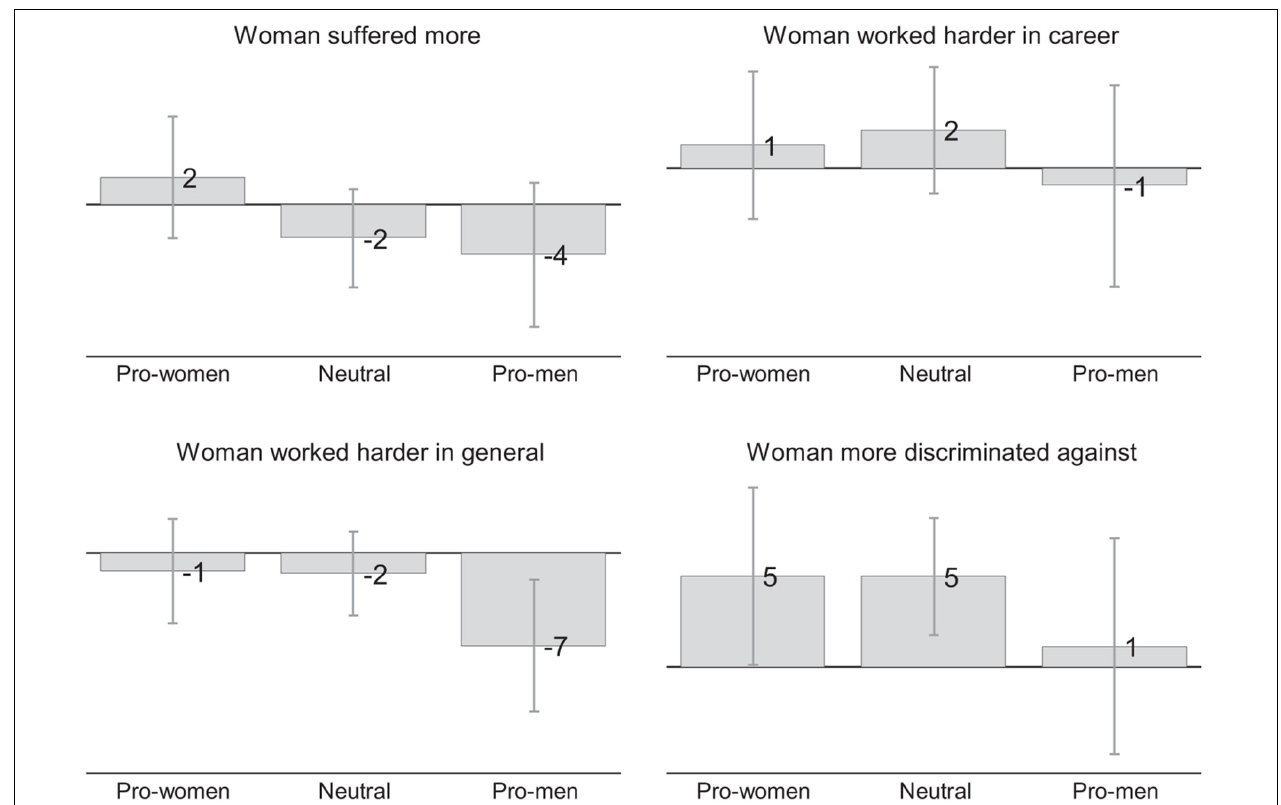
FIGURE 7 | Beliefs about women and men in control scenarios (Qualtrics). This figure is based on responses of Qualtrics respondents who were randomly assigned to the control group. The numbers shown in the figure show belief scores which can range from –50 to +50 where 0 indicates gender neutrality and positive values mean that the statement in the subfigure heading applies more to women. For example, positive values in the left-most figure mean that respondents believe that the women showed in the previous scenarios in the survey experiment would suffer more from not getting the job while negative values mean the opposite. Vertical lines show 95 percent confidence